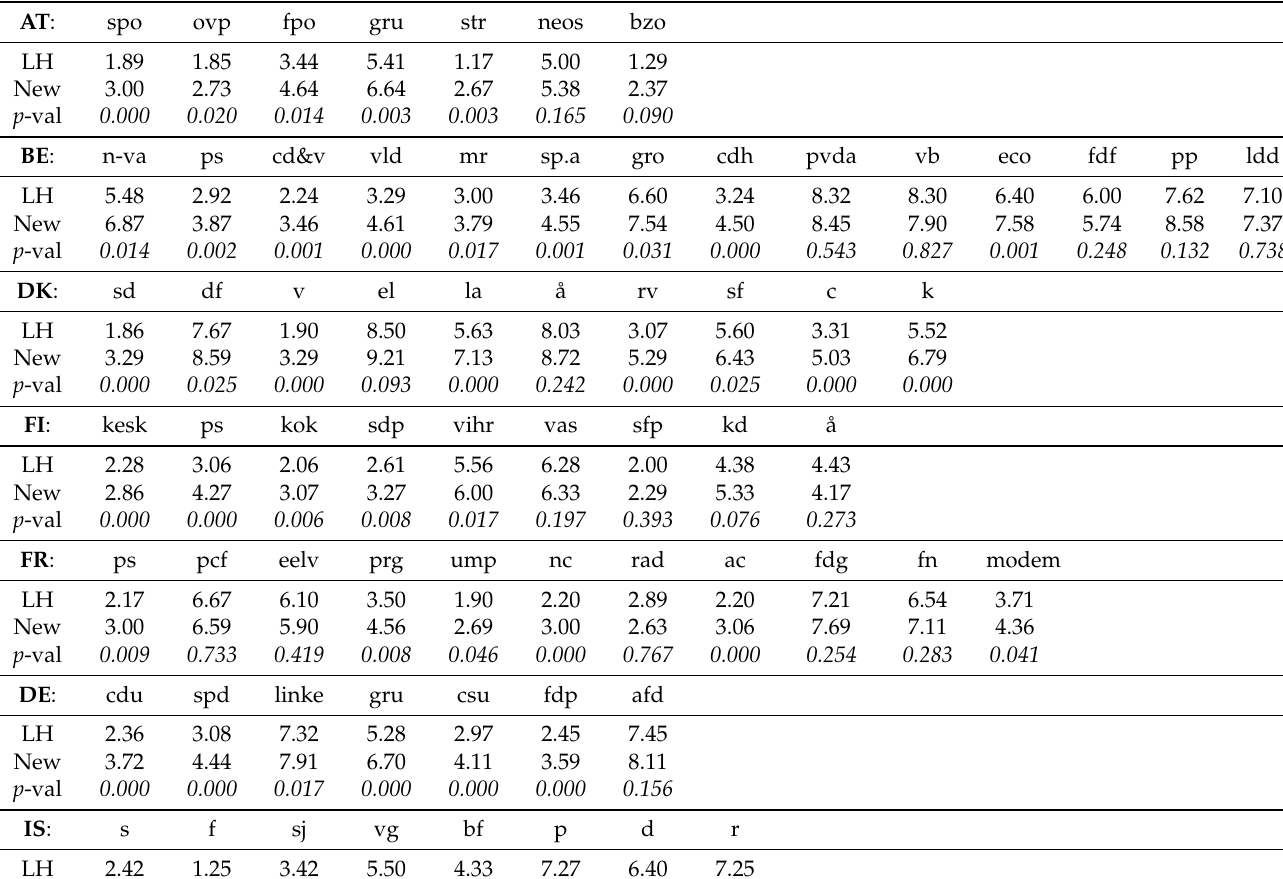
In Table A2 I report the p values for the null hypothesis that the average LH pol/off rating is equal to the average New pol/off rating for each party. Table A2. Policy versus Office